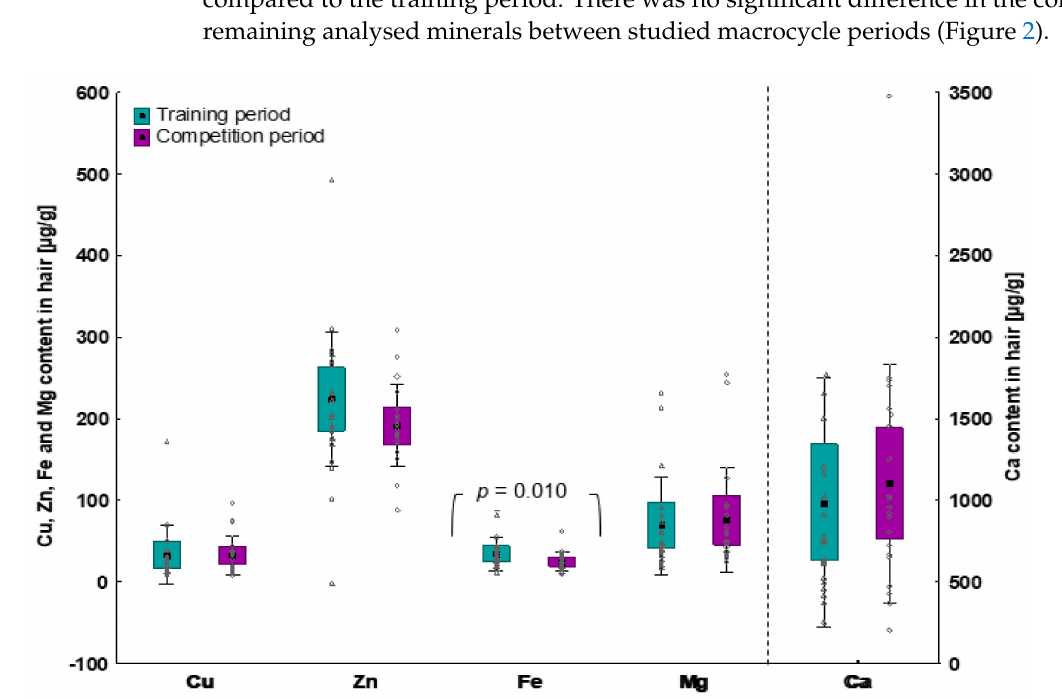
Figure 2. The content of chosen minerals in hair of triathletes during the training and competition period. Data are expressed as means (square), 95% CI (box), 95% CI + SD (whisker), raw data. Data analysed by Wilcoxon signed-rank